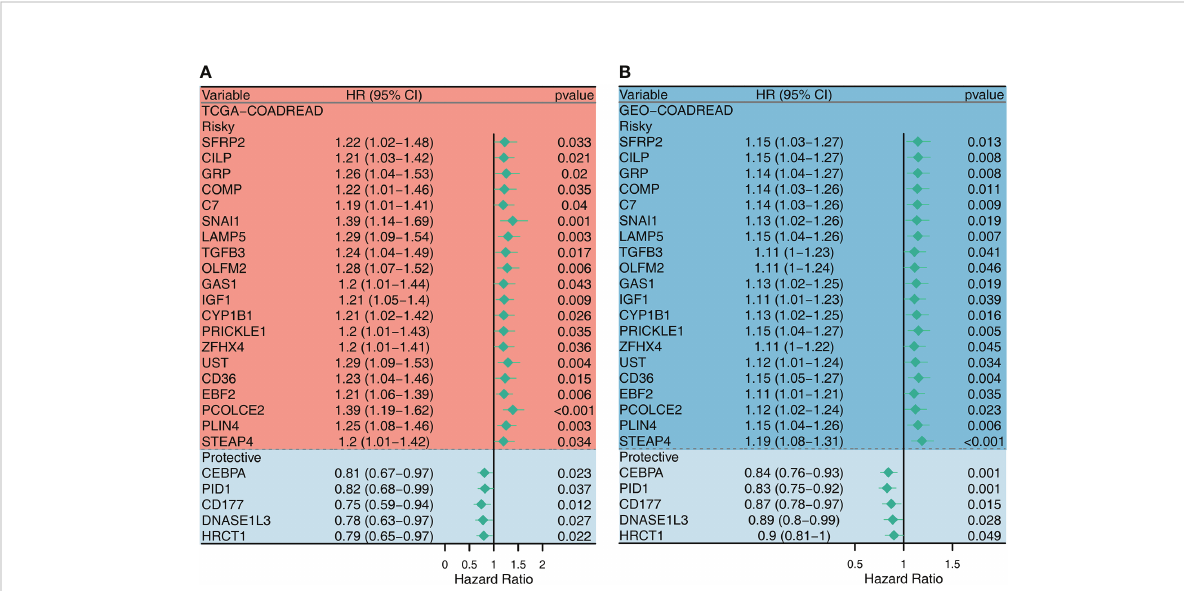
FIGURE 7 Univariate Cox regression analysis for the CAF-related genes in TCGA (A) and GEO (B)